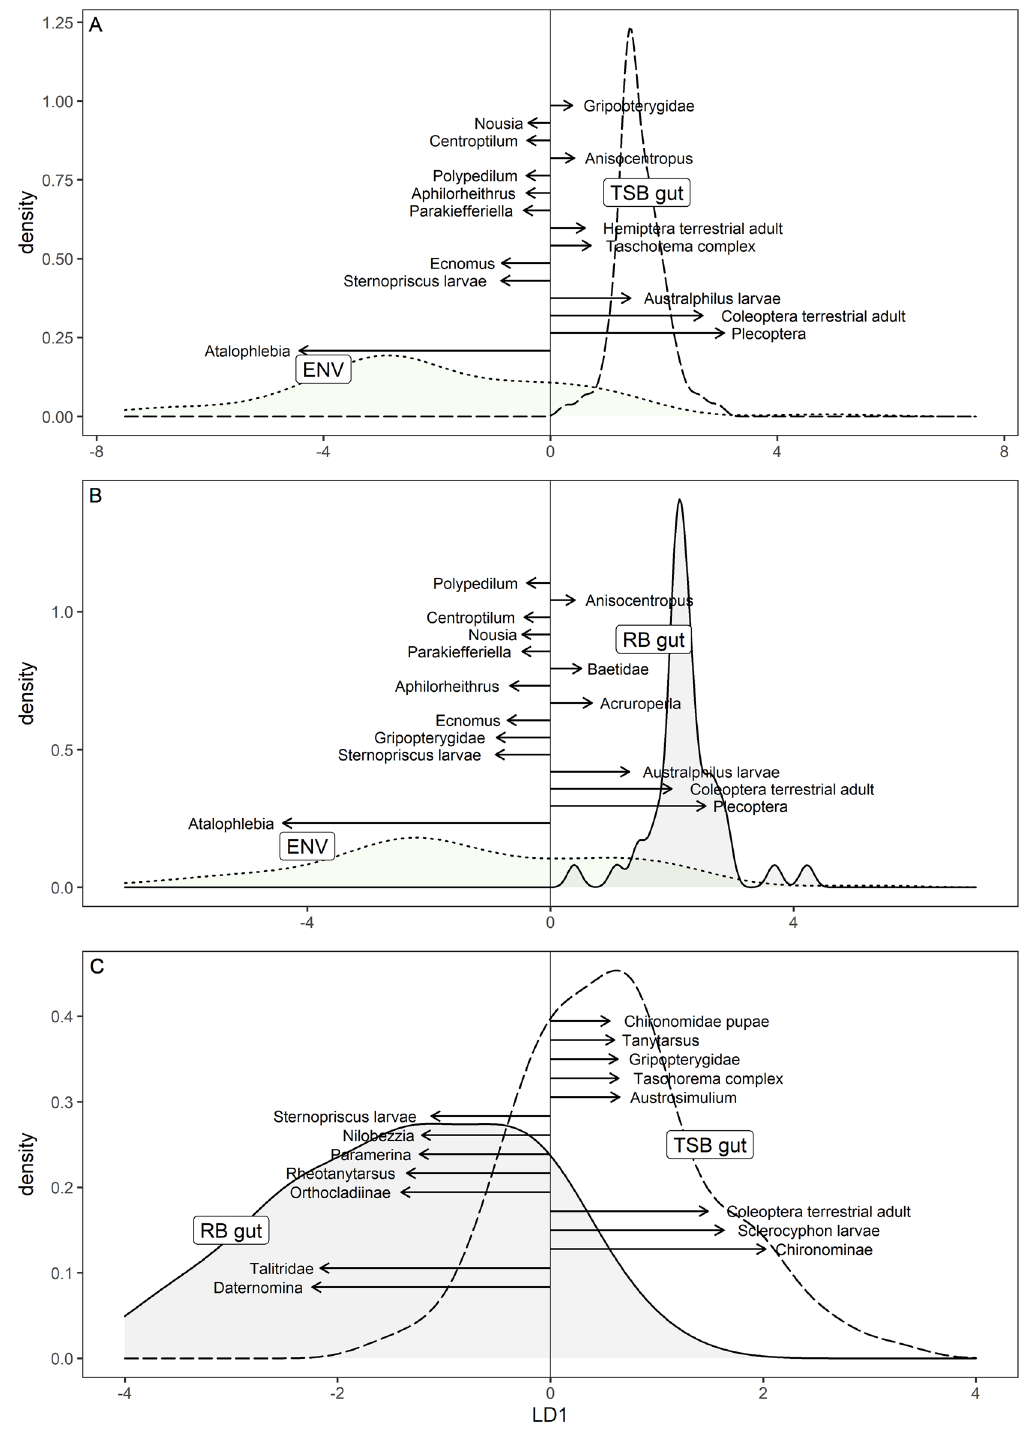
Figure 3. Selection of prey is non-random from the available prey community (ENV; dotted lines; includes, drift, edge and benthos) by ( A ) two-spined blackfish (TSB; dashed lines) and ( B ) river blackfish (RB; solid lines) as determined using weighted linear discriminant analysis (LDA). ( C ) Gut contents also differ in their prey composition between the two species. Only one discriminant function is produced when comparing two groups. The length and direction of vectors show the relative contribution of each taxa to the first discriminant function. Only the top 15 contributors to each function are